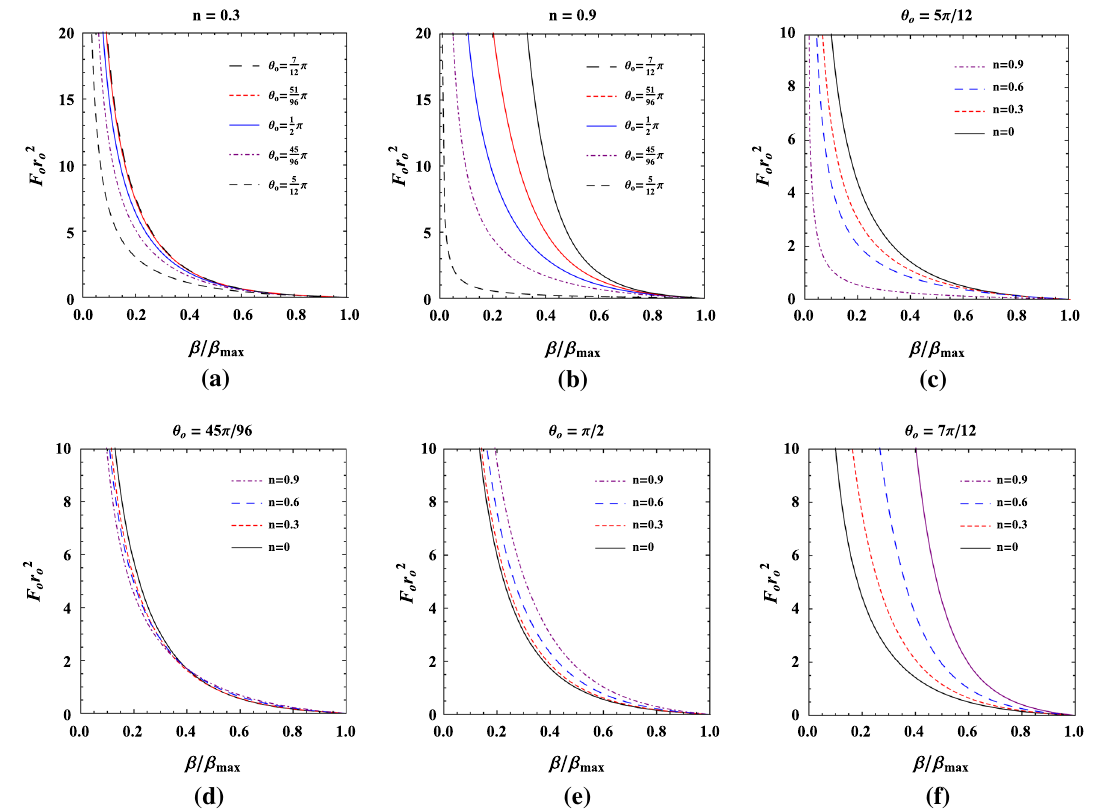
Fig. 3 The change of the flux F o at observer with the angular coordinate β/β max for different NUT charge n and the observer’s angular position θ o as the source lies in the NHEKTN line. Here, we set M